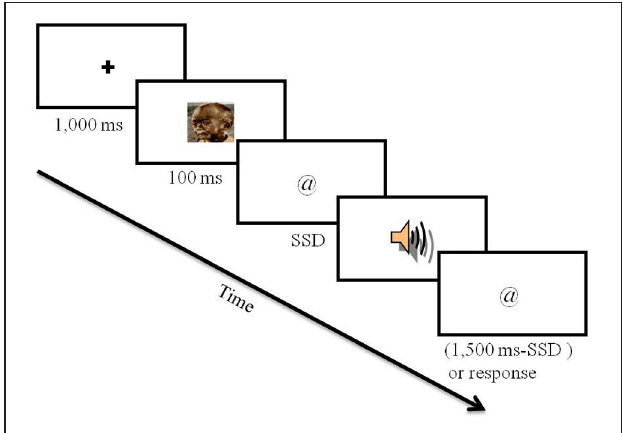
FIGURE 1 | Experimental procedure. Example of a negative stop-signal